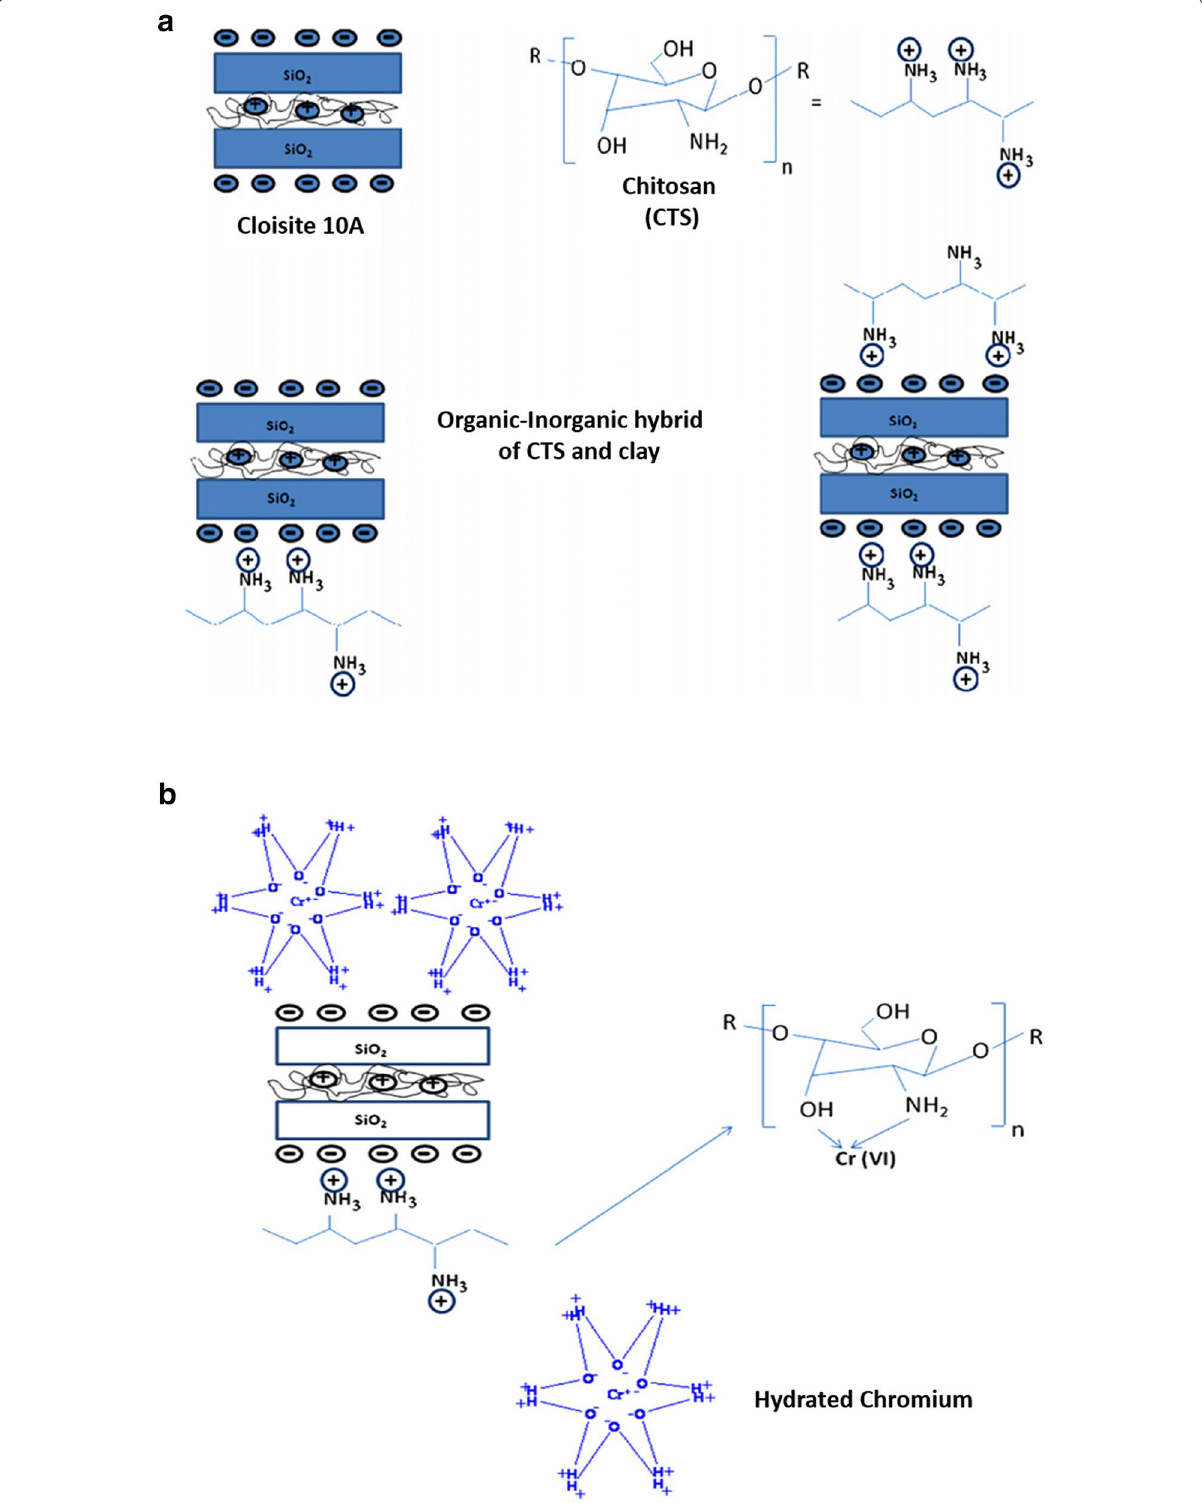
Fig. 7 a CTS/clay-based Organic–inorganic hybrid, and b the interaction mechanism of CTS/organoclay and Cr 6 + . (Reprinted from